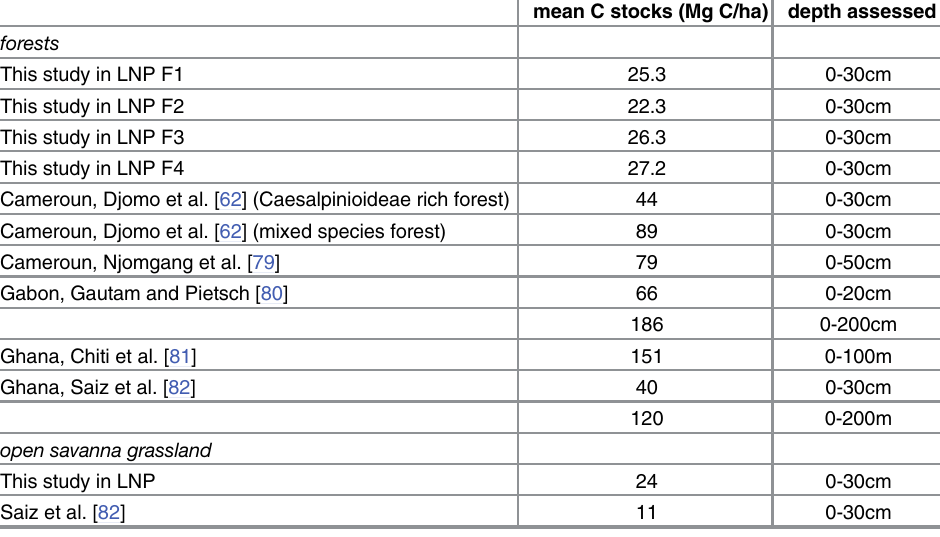
Table 5. Mean soil Carbon stocks in this study and several studies available in